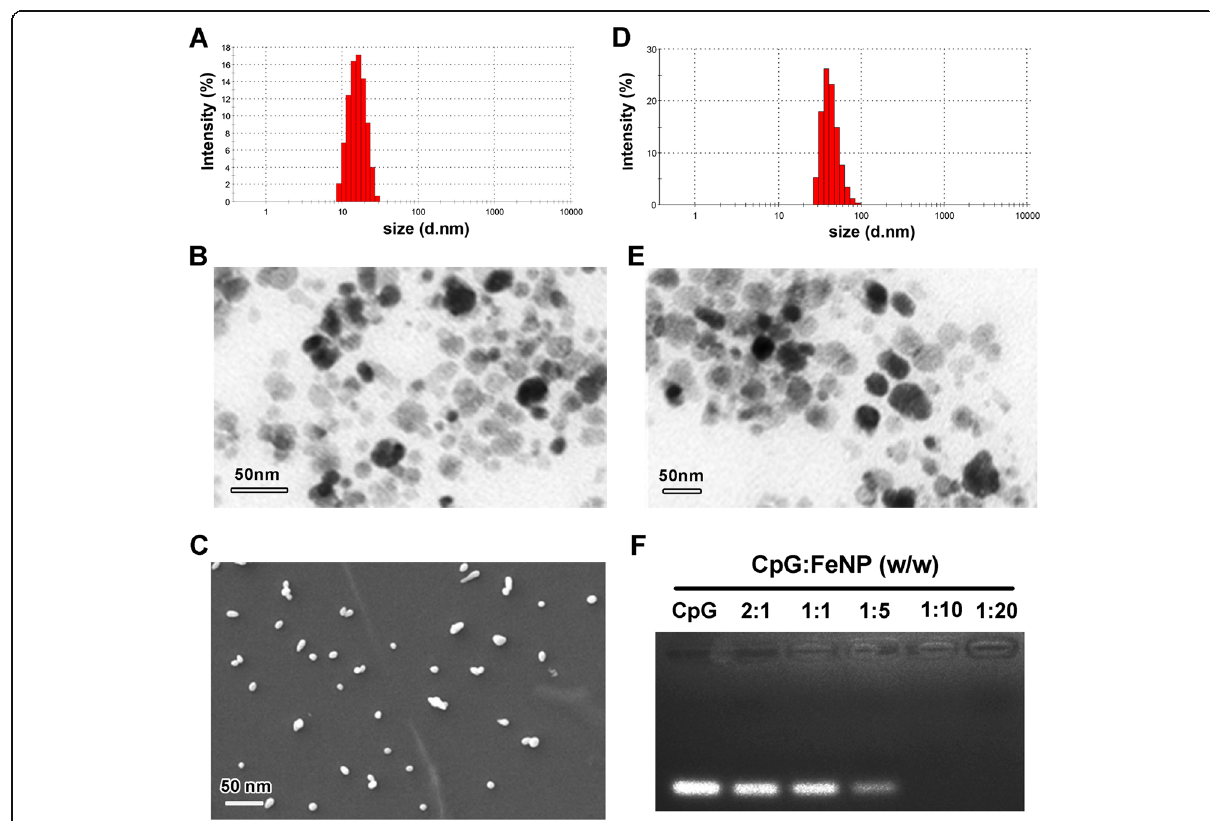
Fig. 2 Characterization of FeNP/CpG particles. a Size distribution spectrum of Fe 3 O 4 particles. b Transmission electron microscopic image (TEM) of Fe 3 O 4 . c Scanning electron microscopy image of Fe 3 O 4 particles. d Size distribution of APTES-coated Fe 3 O 4 (FeNP) particles. e The TEM image of FeNP particles. f The CpG binding ability of FeNPs determined by gel retardation assay. All data represent three independent